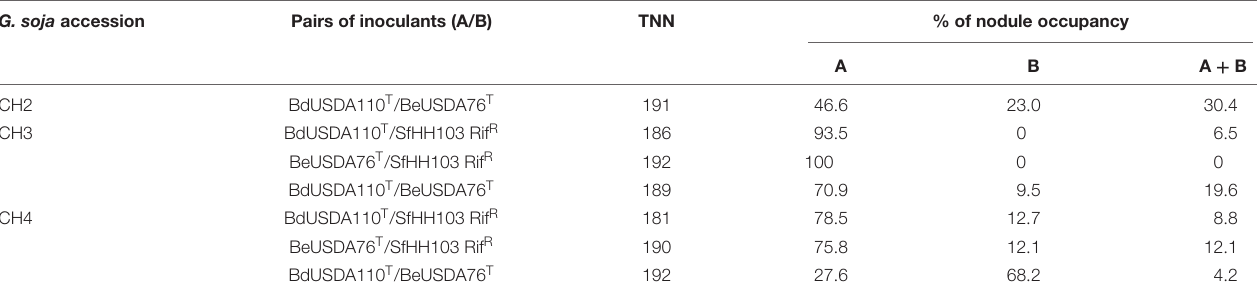
TABLE 3 | Nodule occupancy of Glycine soja accessions CH2, CH3, and CH4 inoculated with pairs of competitors formed among B. diazoefficiens (Bd) USDA110 T , B. elkanii (Be) USDA76 T or S. fredii (Sf) HH103 Rif R . G. soja accession Pairs of inoculants (A/B) TNN